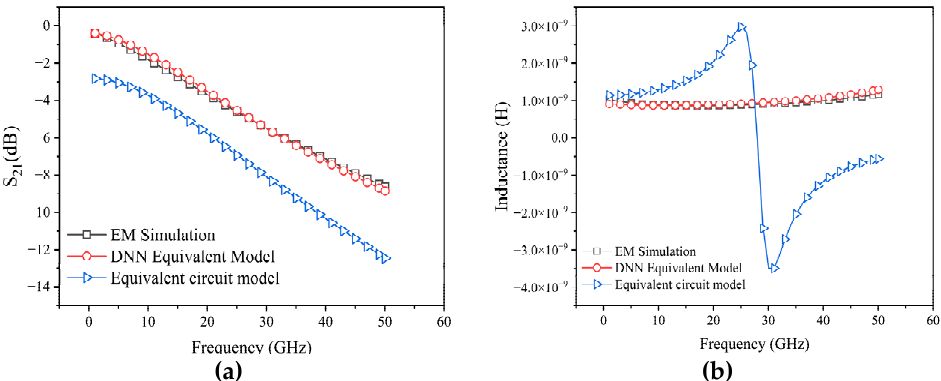
Figure 10. S-parameters (S 21 ) and inductance values for a metal filling density of 80%; ( a ) shows S-parameters (S 21 ) and ( b ) shows inductance values.